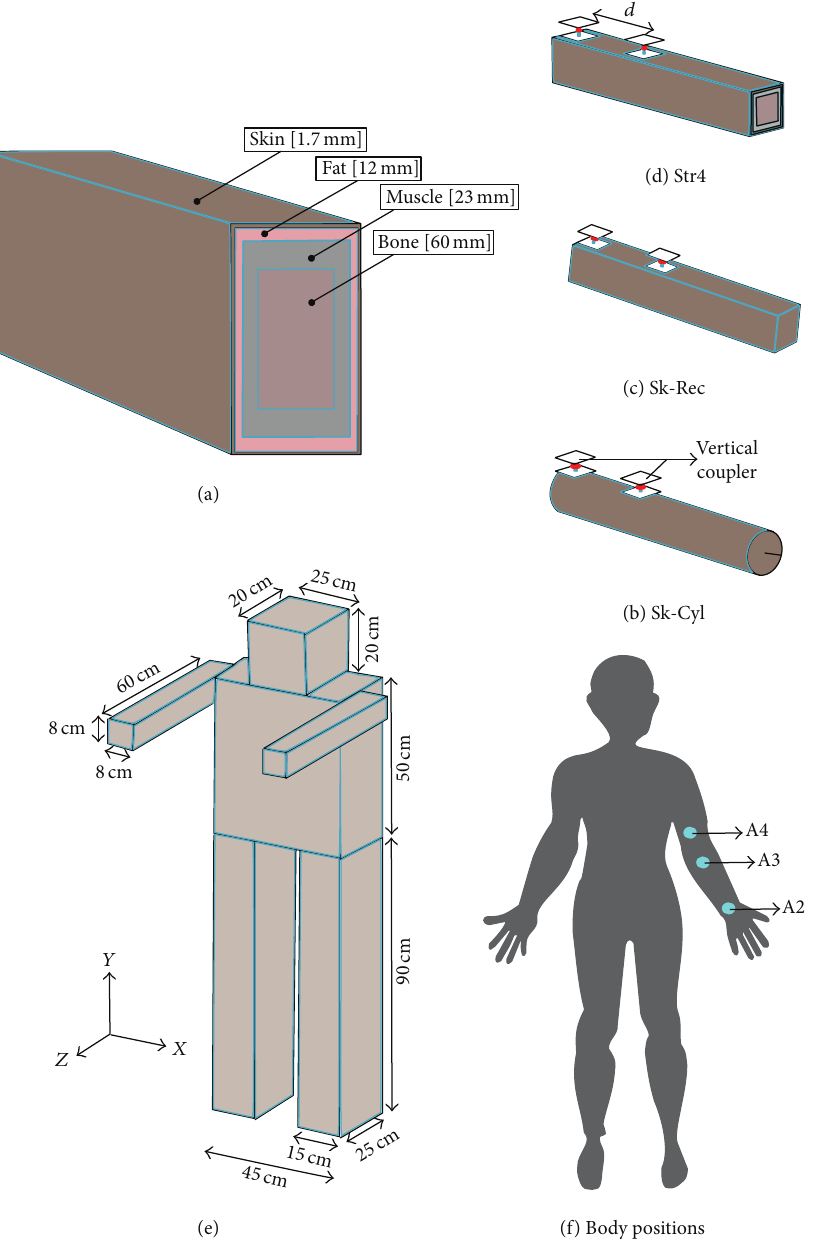
Figure 3: Comparison of different models with couplers (shown for vertical electrodes only). (a) Cross-sectional view of the standard four- layer-stratified (Str4) human arm model (layer thickness is shown in square brackets), (b) skin-only-cylinder (Sk-Cyl) model, (c) skin- only-rectangle (Sk-Rec) model, (d) standard four-layer-stratified (Str4) model, (e) the skin-only-rectangle human body model with all the dimensions, and (f) body positions for validation with the measurements from